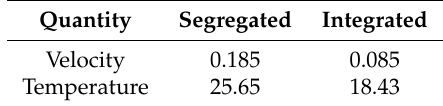
Table 6. Comparison between the χ 2 for the segregated method and the integrated